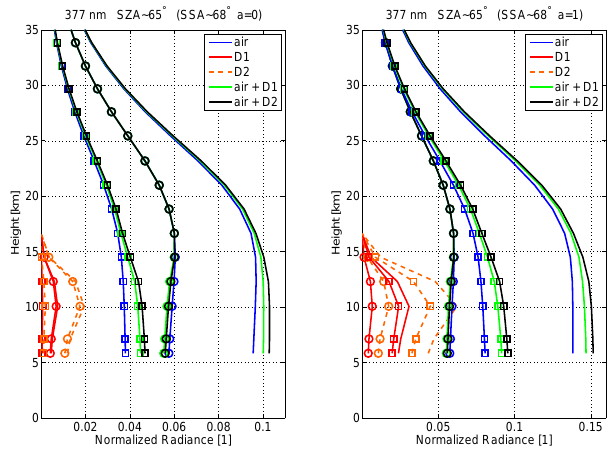
Fig. 4. As in Fig. 1 but at